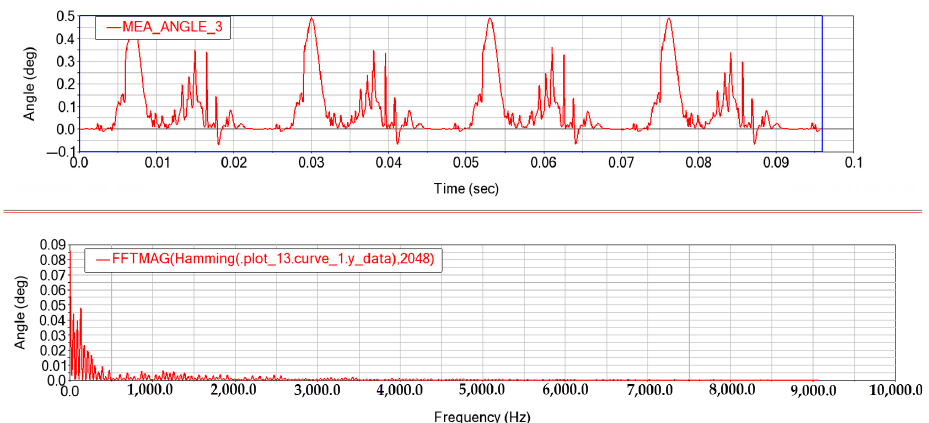
Figure 32. The 2600 r/min free end torsional vibration.